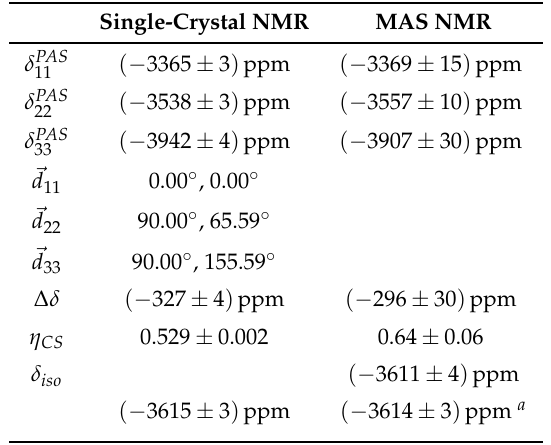
Table 1. Chemical shift tensor δ CRY of 207 Pb in the anglesite structure. Left: Determined from single-crystal NMR experiments about two rotation axes at room temperature. The orientations of the corresponding eigenvectors are listed in spherical co-ordinates ( θ , ϕ ) in the orthorhombic abc crystal system CRY and refer to the atom closest to the origin, i.e., Pb(1). Error values are derived from the fit residuals. Right: Determined from a H ERZFELD –B ERGER analysis [7] of the rotational side-band pattern at ν r = + 12.5 kHz magic-angle spinning (MAS) (i.e., at slightly elevated temperature), with I 2 / I 0 = 0.24, and I 3 / I 0 = 0.054, leading to ρ = − 0.3 ± 0.04 and µ = 4.5 ± 0.3. 1 / I 0 = 0.52, I − − − The error values of the tensor components are derived from those of ρ and µ